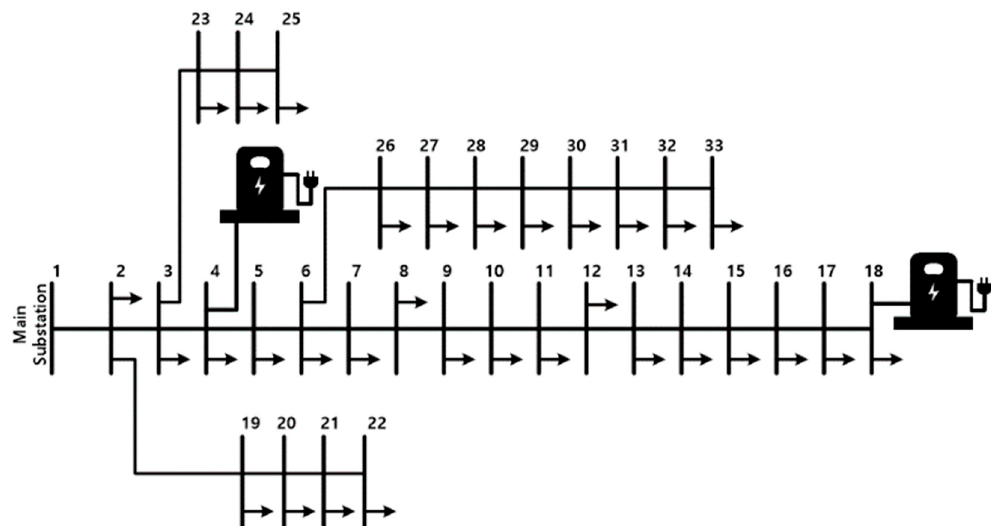
Figure 4. Modified IEEE 33 test bus system with two CSs.